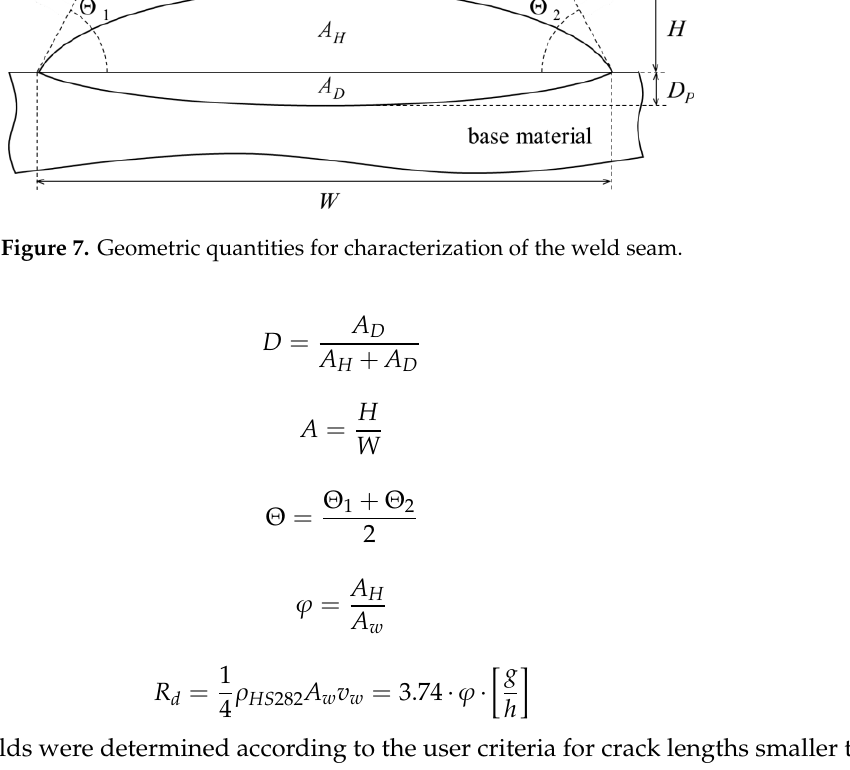
Table 4. Investigated parameters and further welding and monitoring conditions.